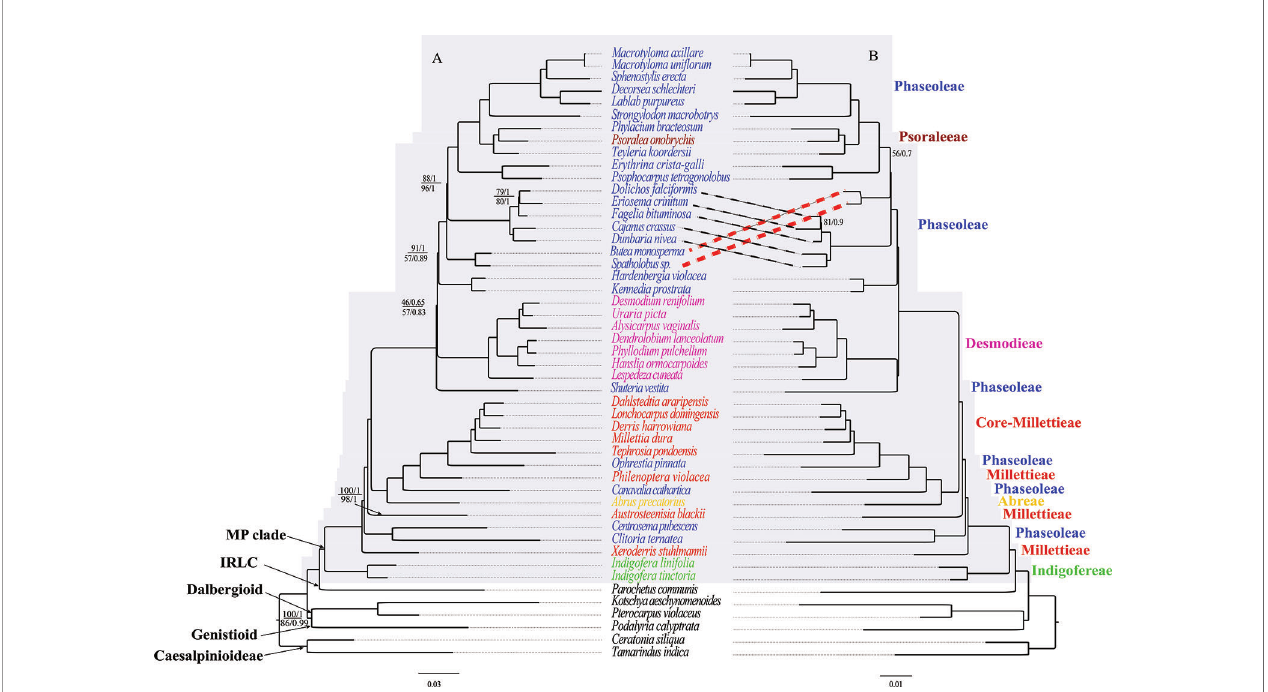
FIGURE 4 | The ML and BI phylogenetic relationships reconstructed for the MP clade. (A) CP and NCDs, and (B) CDs. Numbers at nodes correspond to ML bootstrap percentages (only values <100% are shown) and Bayesian inference (BI) posterior probabilities (only probabilities <1.0 are shown). For (A) , the values above and below the line represents support values for the CP and NCDs, respectively. The thick dotted lines indicate topology differences. The scale bar represents the mean nucleotide substitutions per site along the